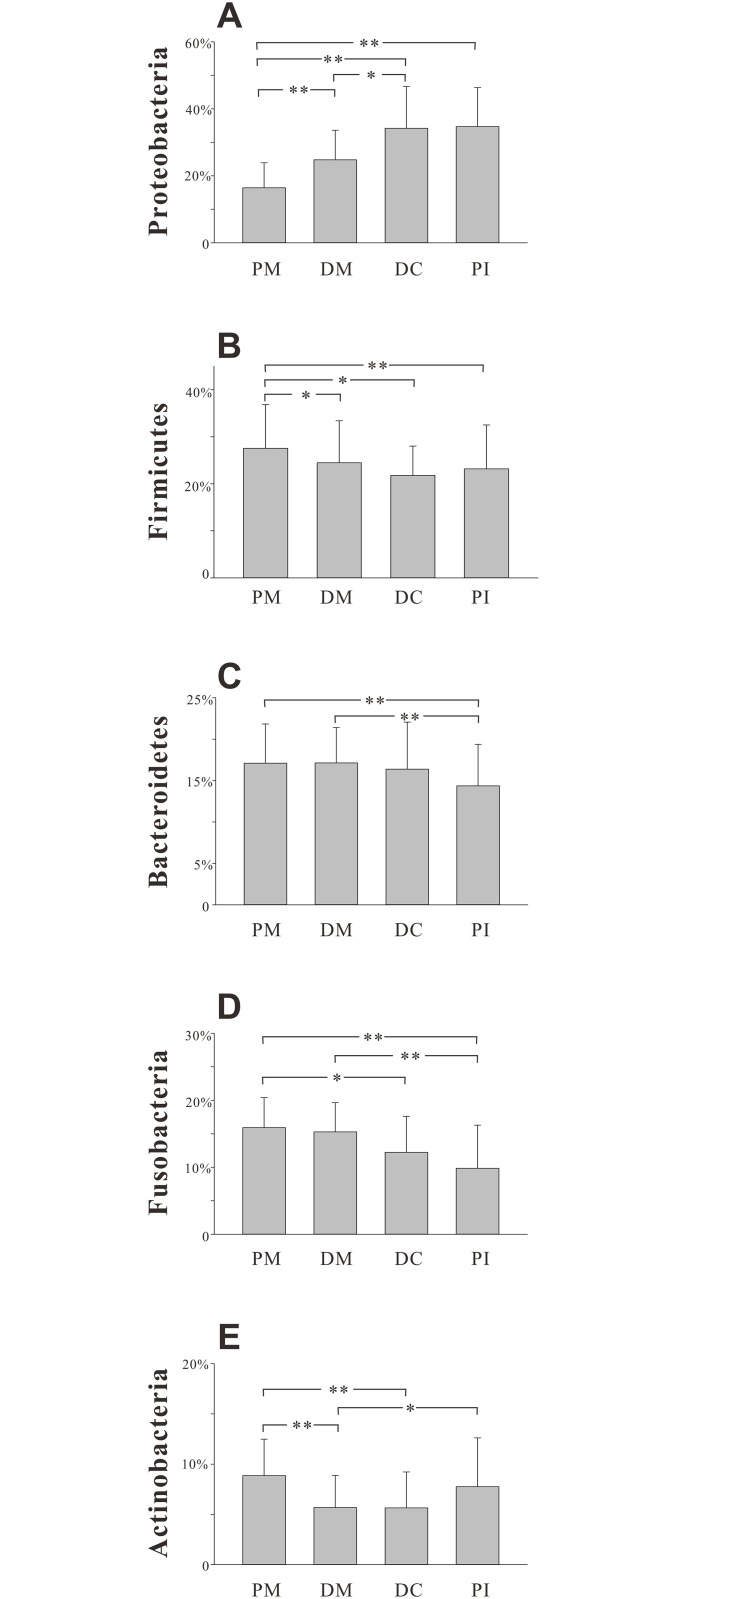
Relative abundances of the main bacterial phyla identified in dentition sites.A–E. Relative abundances of Proteobacteria, Firmicutes, Bacteroidetes, Fusobacteria and Actinobacteria in the four groups. The four groups are presented in distal—mesial order according to location in the dentition. All data are presented as means with standard deviations. *P < 0.05, **P < 0.01 by two-tailed t-test.